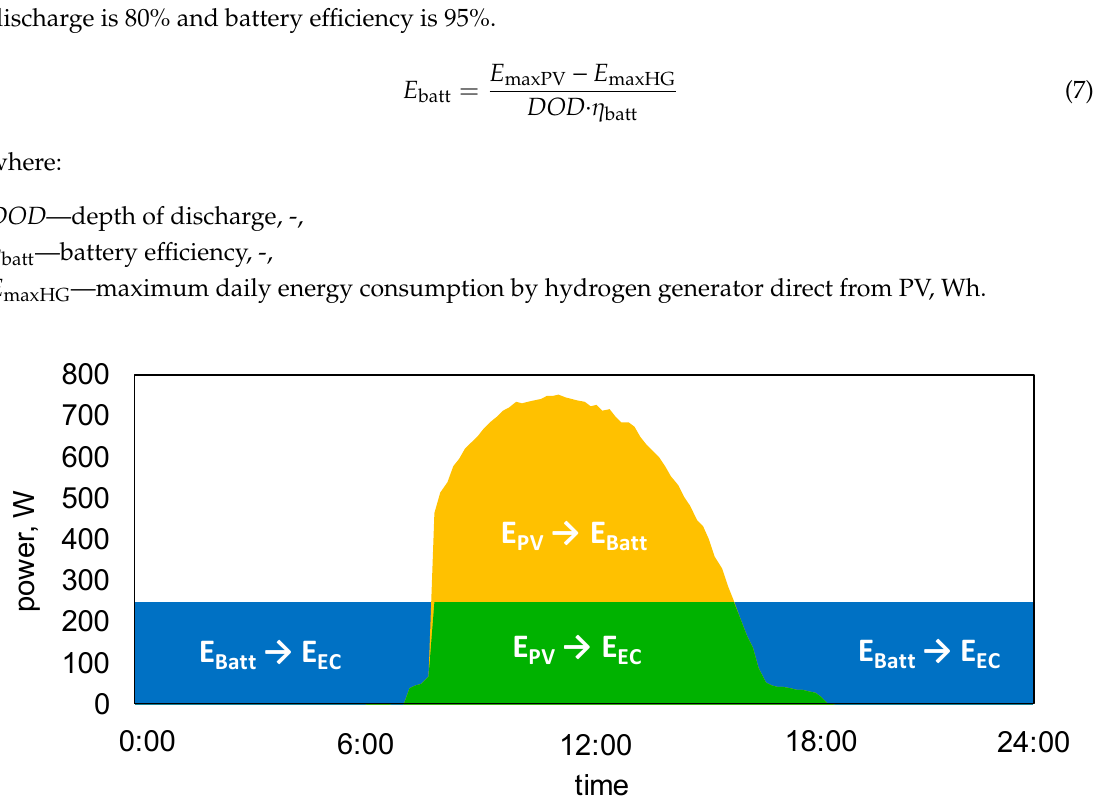
Figure 15. Daily energy generation by 1 kW p PV system (location: 50°17 ′ 36 ″ N 18°40 ′ 55 ″ E; PV panels were positioned 50° to the horizontal and faced 30° southeast (SE)). Data from 2016.